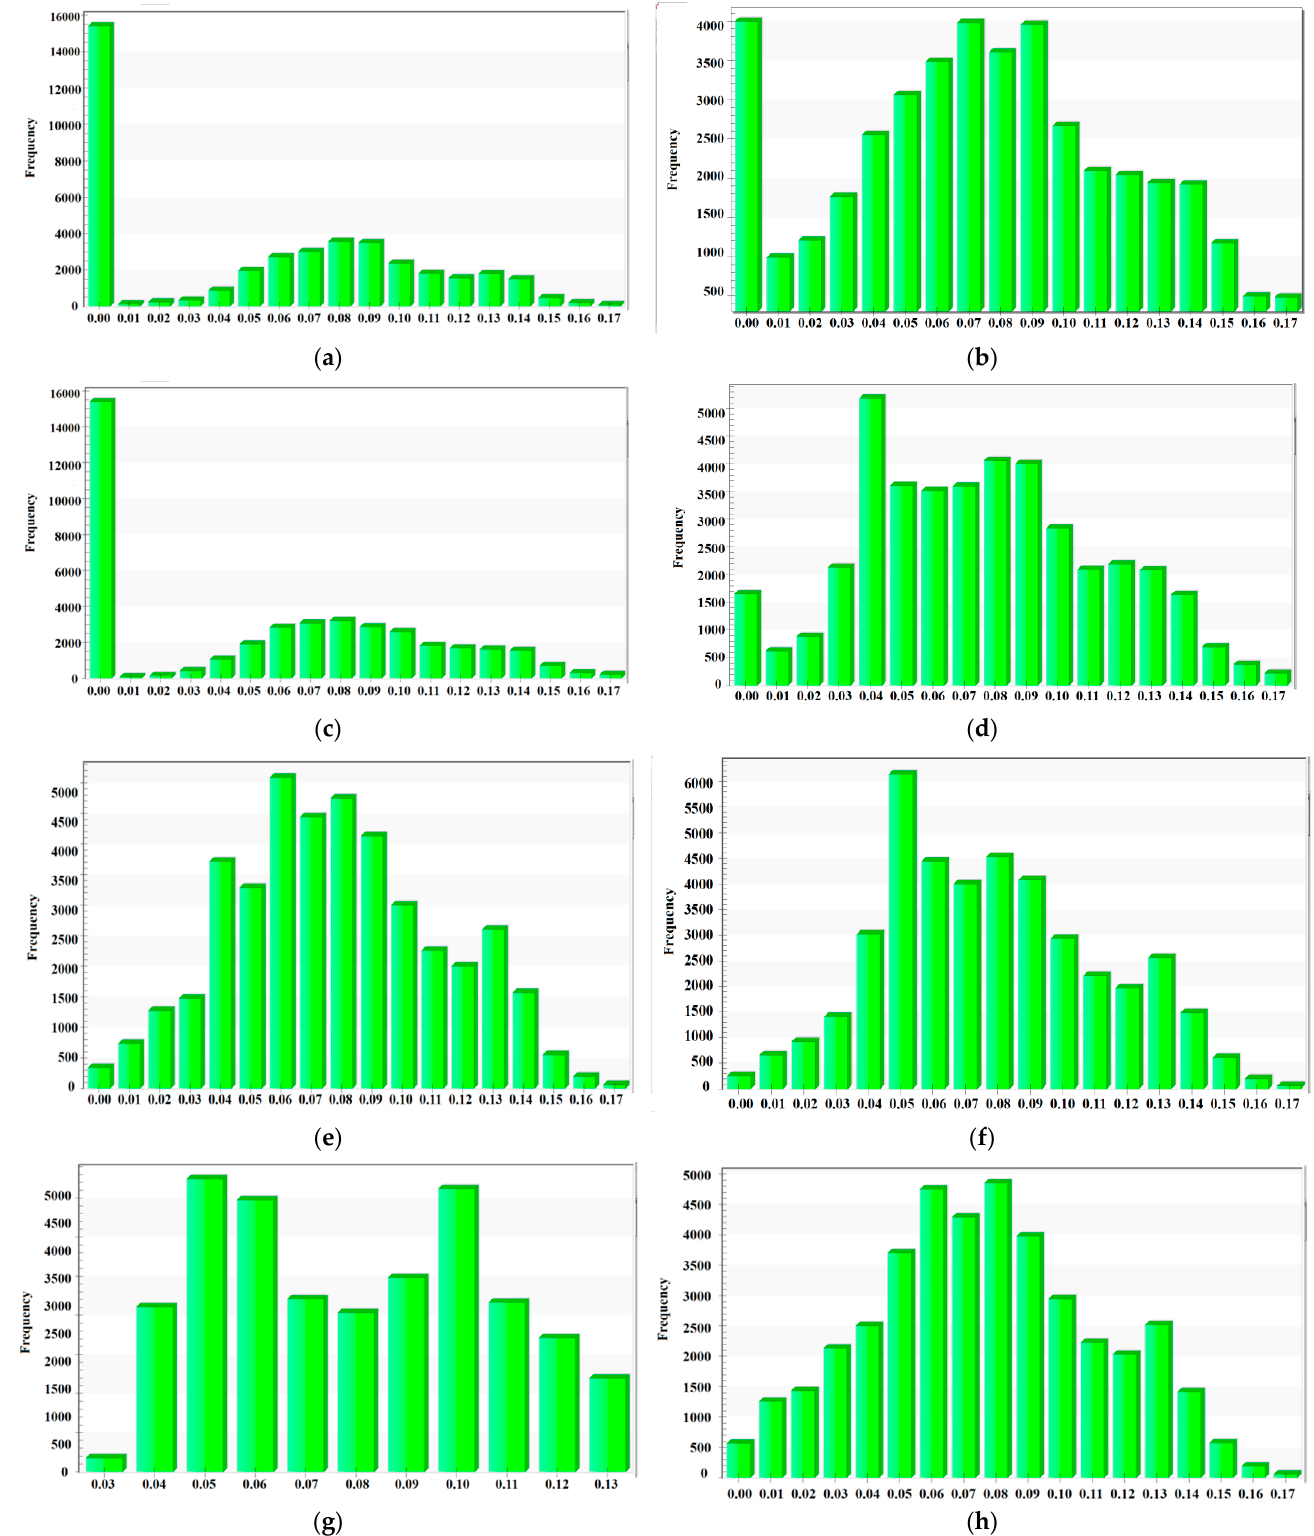
Figure 3. Frequency histogram of uranium grade distribution under different interpolation algo- rithms. ( a ) Linear(interval = 18); ( b ) IDW(interval = 18); ( c ) CT(interval = 18); ( d ) NN(interval = 18); ( e ) OK(spherical)(interval = 18); ( f ) OK(exponential)(interval = 18); ( g ) OK(gaussian)(interval = 11); ( h ) OK(power)(interval =